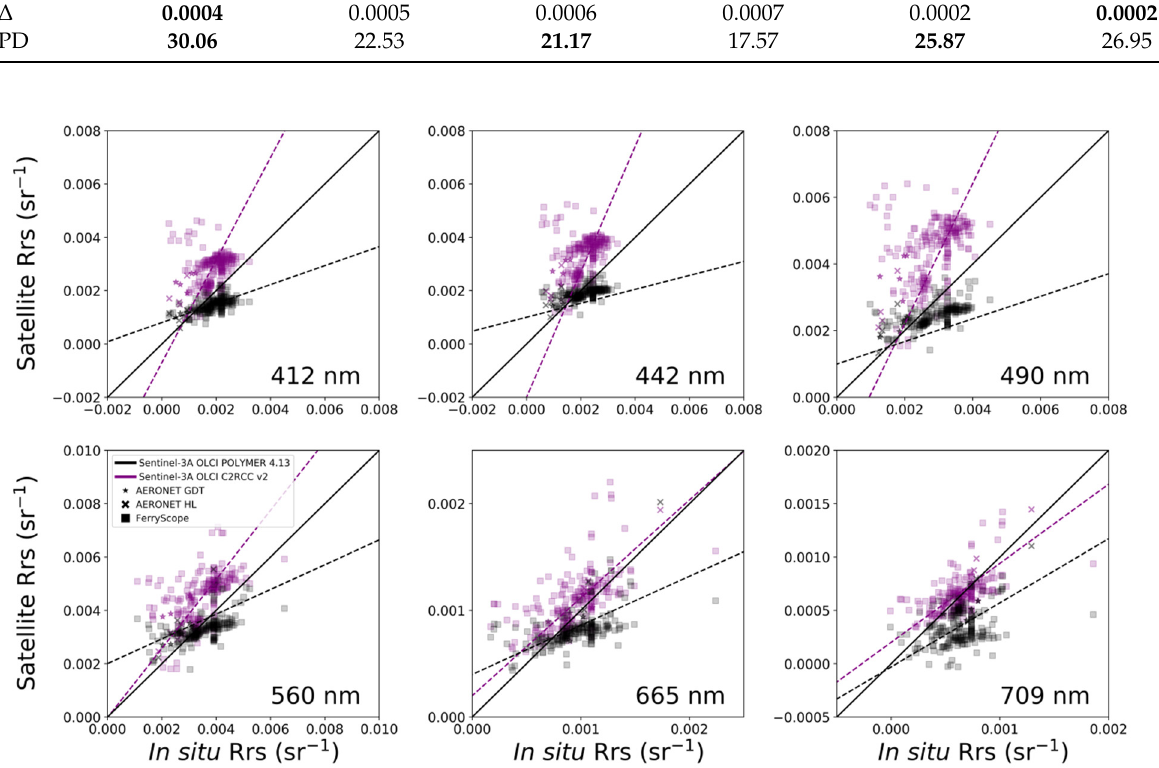
Figure 5. Scatter plots of satellite R rs versus in situ R rs for OLCI-A POLYMER v4.13 (black points and dashed line), OLCI-A C2R-CC vSnap8 (purple points and dashed line) at 412, 442, 490, 560, 665 and 709 nm. Crosses are in situ AERONET-OC HLT R rs , stars are in situ AERONET-OC GDL R rs , squares are in situ Alg@line R rs .